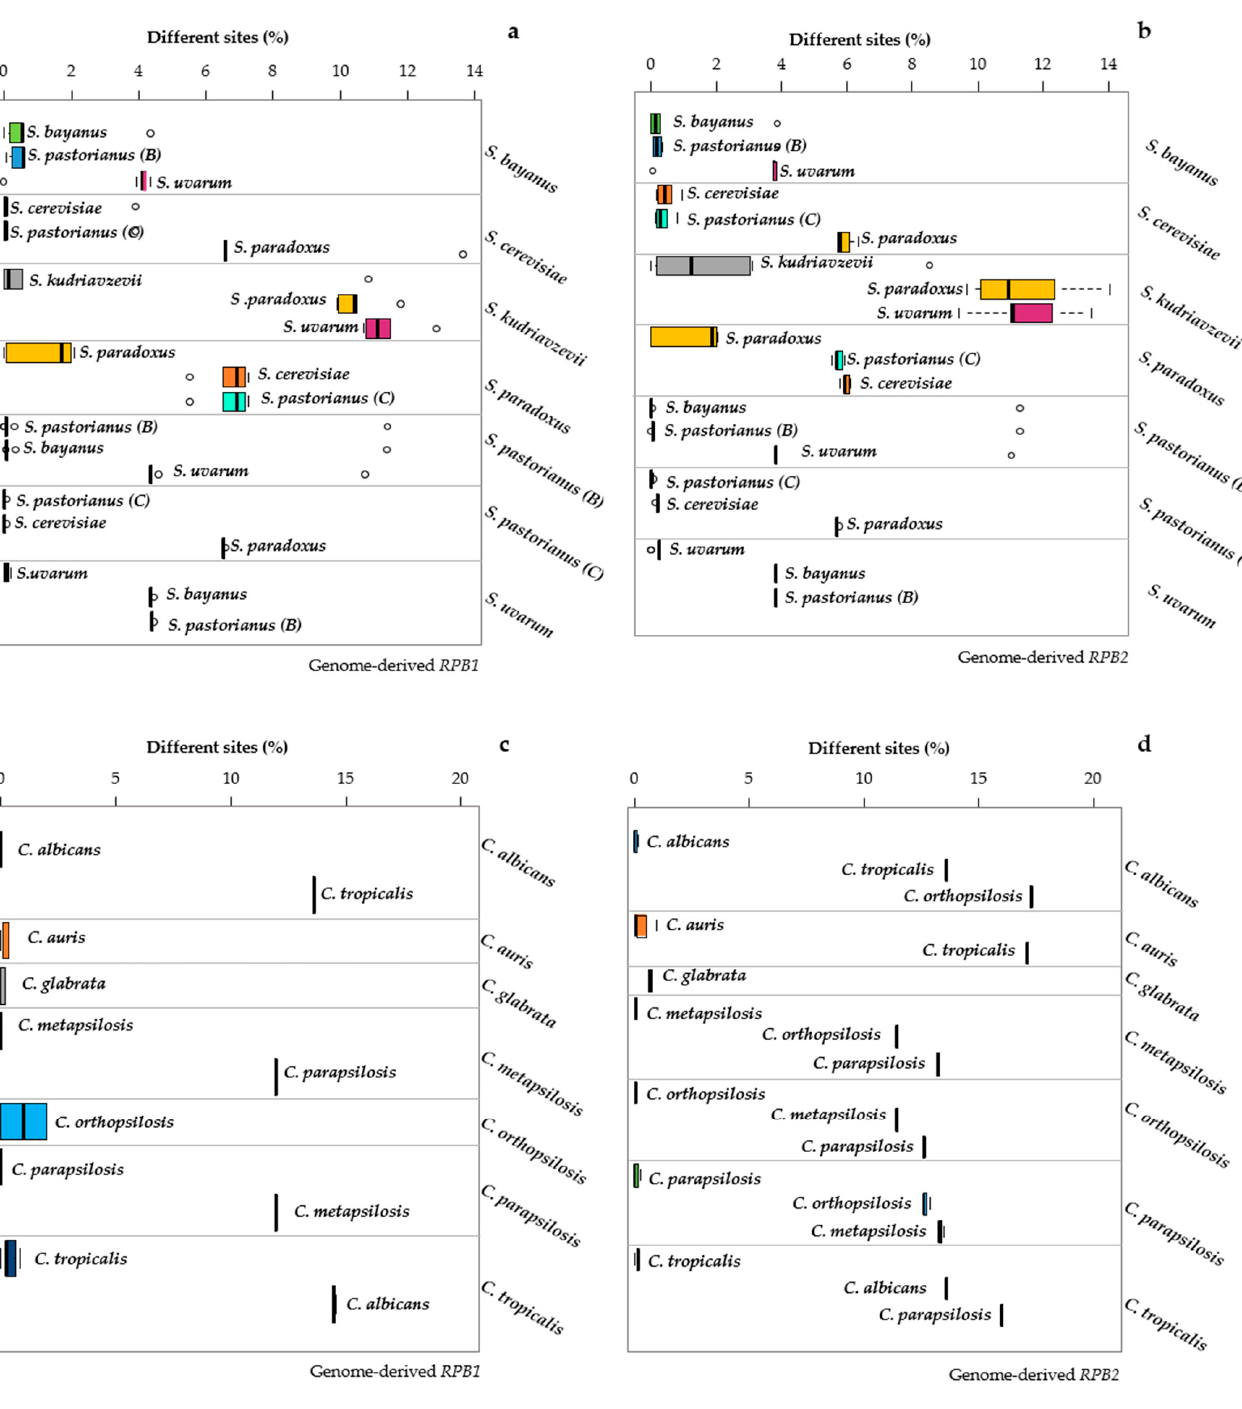
Figure 6. Distance among and within the Candida and Saccharomyces species. Resolutions calculated for genomic RPB1 and genomic RPB2 of Saccharomyces are displayed in panels ( a , b ), respectively. Genomic RPB1 and genomic RPB2 of Candida are reported in panels ( c , d ). Each subpanel reports the distances of the strains belonging to the species under study (indicated on the right of the subpanel) with the sequences of the type strain of the three closest species (indicated close to the box). The width of each box represents the variability of the distances of the strains of each species from the type strains of the three closest species. The internal variability of each species is indicated by the topmost box of each subpanel. The distances among the means of the species are displayed as the distances between the vertical thick segments within the